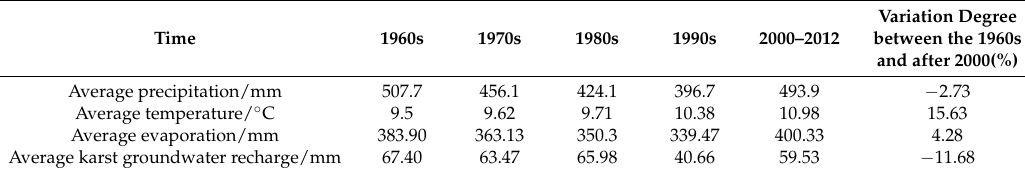
Table 1. Annual average precipitation, temperature, and evaporation for each time period in the Jinci Spring region: Statistical Table.